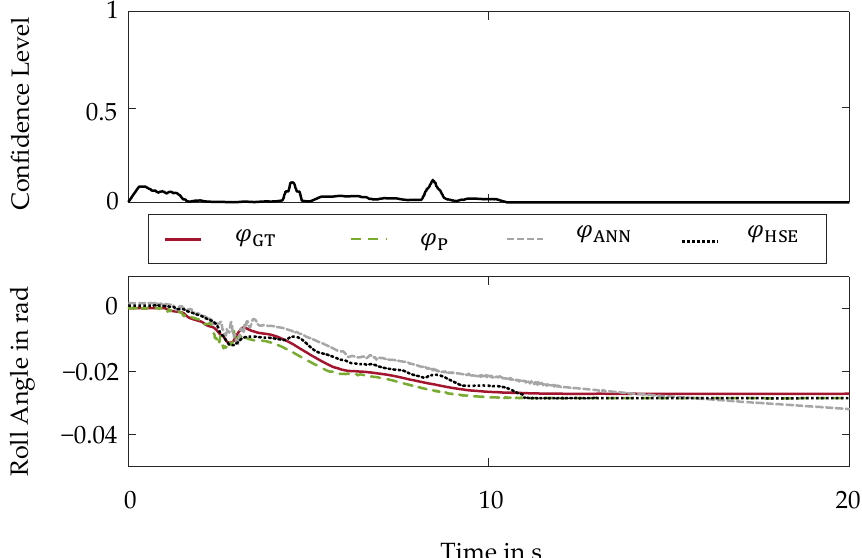
Figure 4. Hybrid Method of State Estimation-Sensor Drift: ( Top ): Confidence Level; ( Bottom ): Roll Angle Curves.